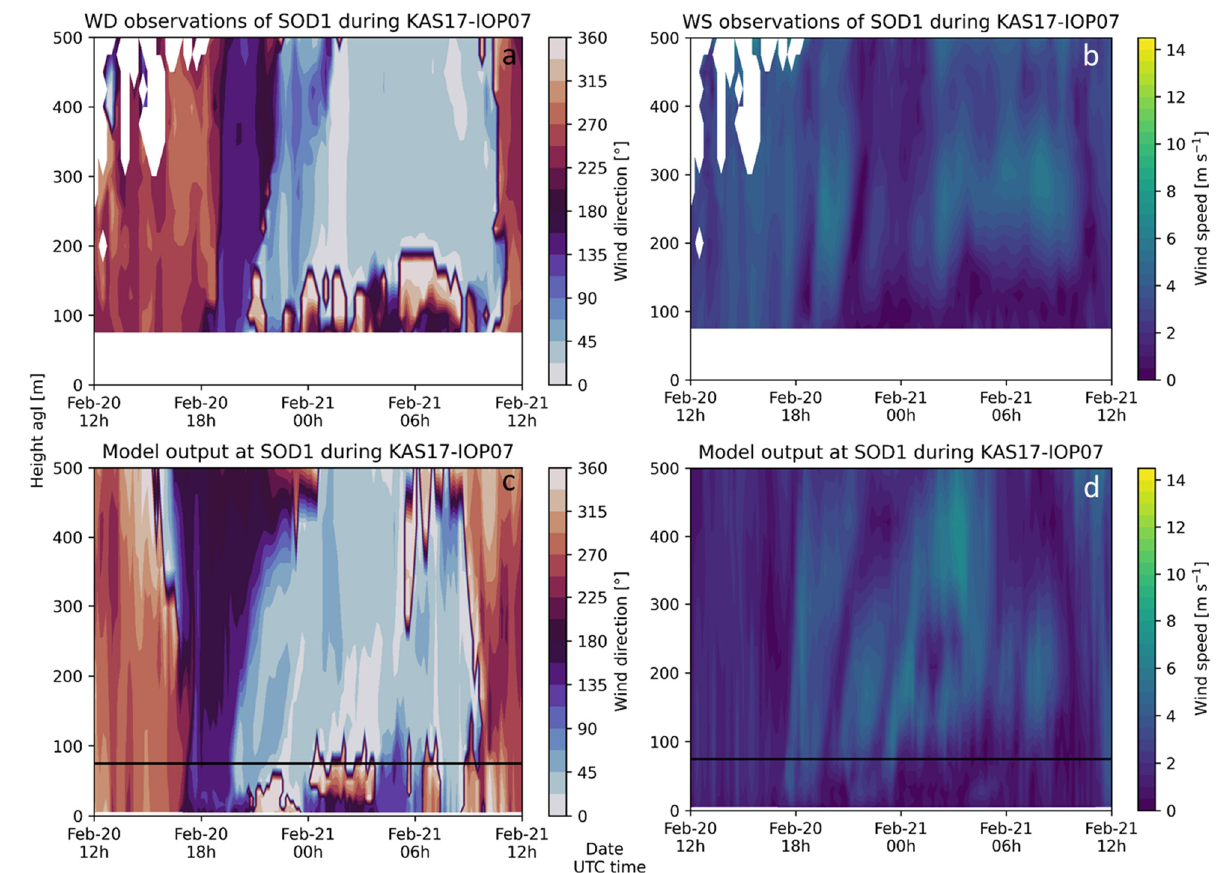
Figure 8. Time–height diagram of wind direction ( left ) and speed ( right ) above the MET01 site (center of the CV), observed by the sodar ( top ) and simulated ( bottom ). Black lines in simulated plots indicate the lowest height of sodar observations.